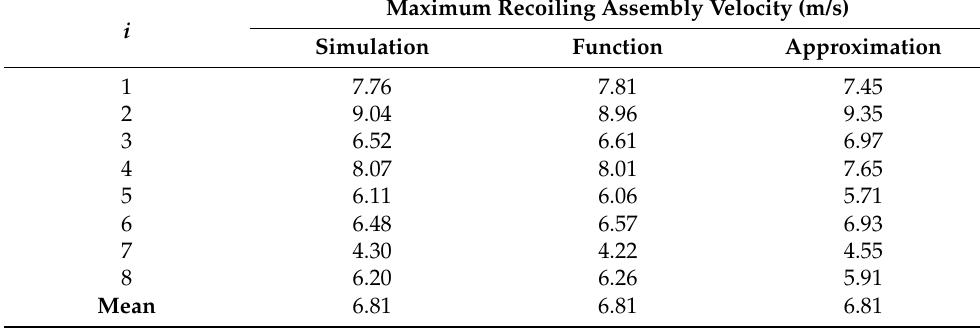
Table 7. The results of simulation compared to the results approximated by the obtained function—for the second plan.